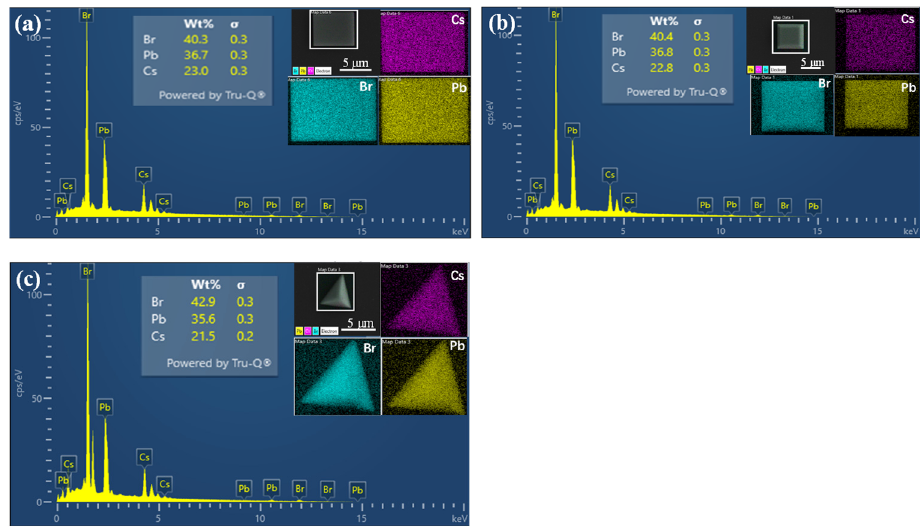
Figure 4. The EDS spectra and corresponding elemental mappings of the microplate ( a ), frustum of a square pyramid ( b ) and pyramid ( c ).